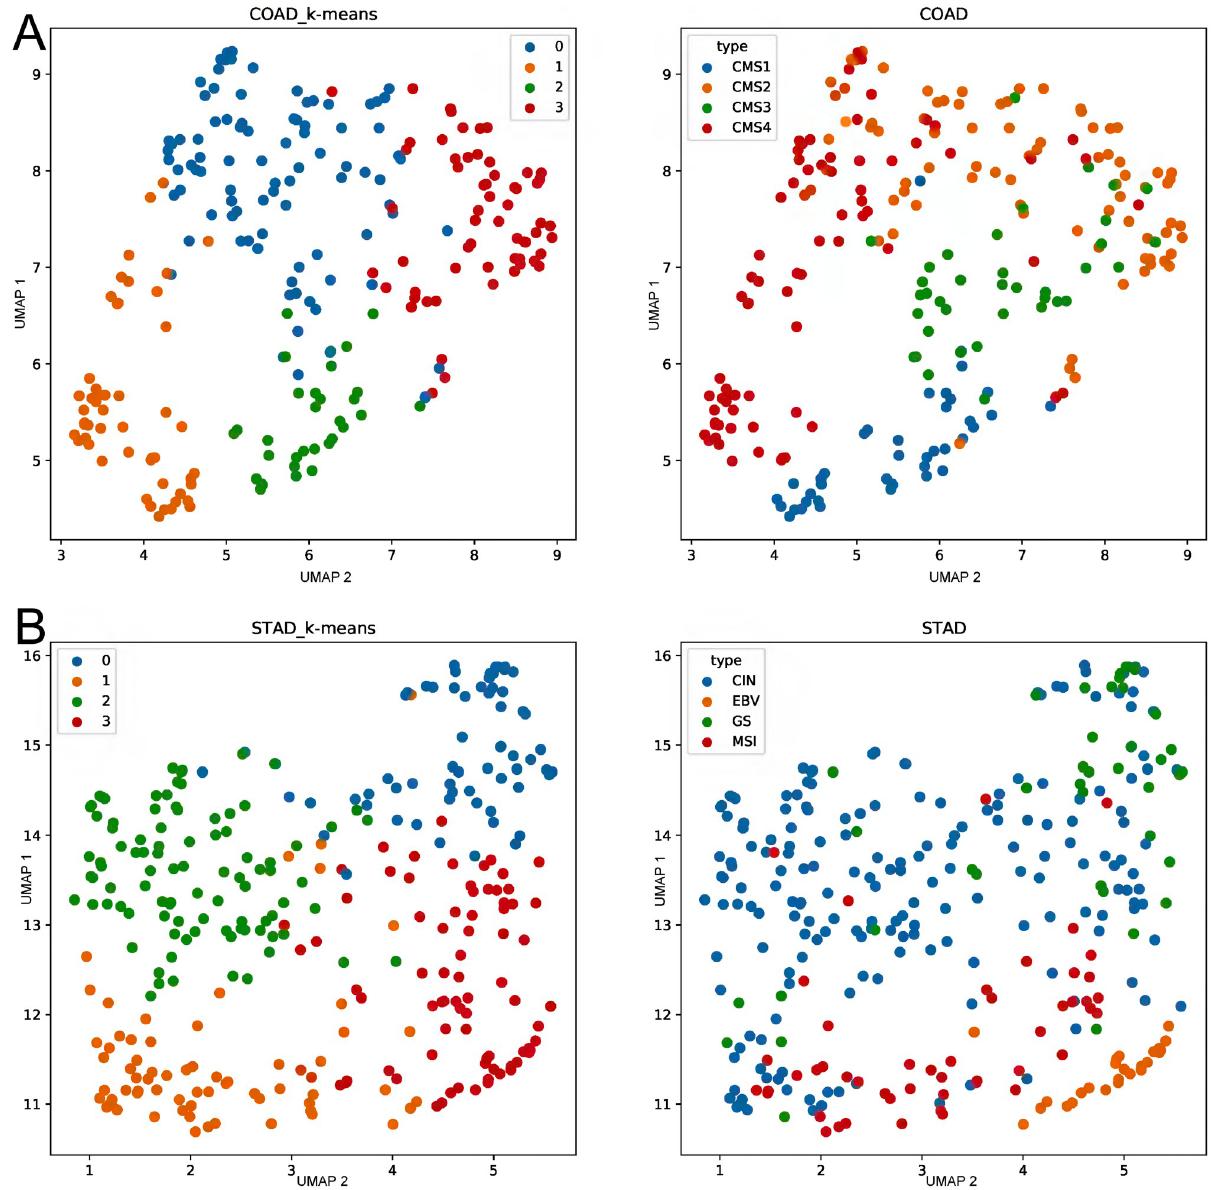
Fig 8. The K-means clustering result using mES of COAD and STAD. The (A) COAD and (B) STAD ground truth subtype labels were well recovered.